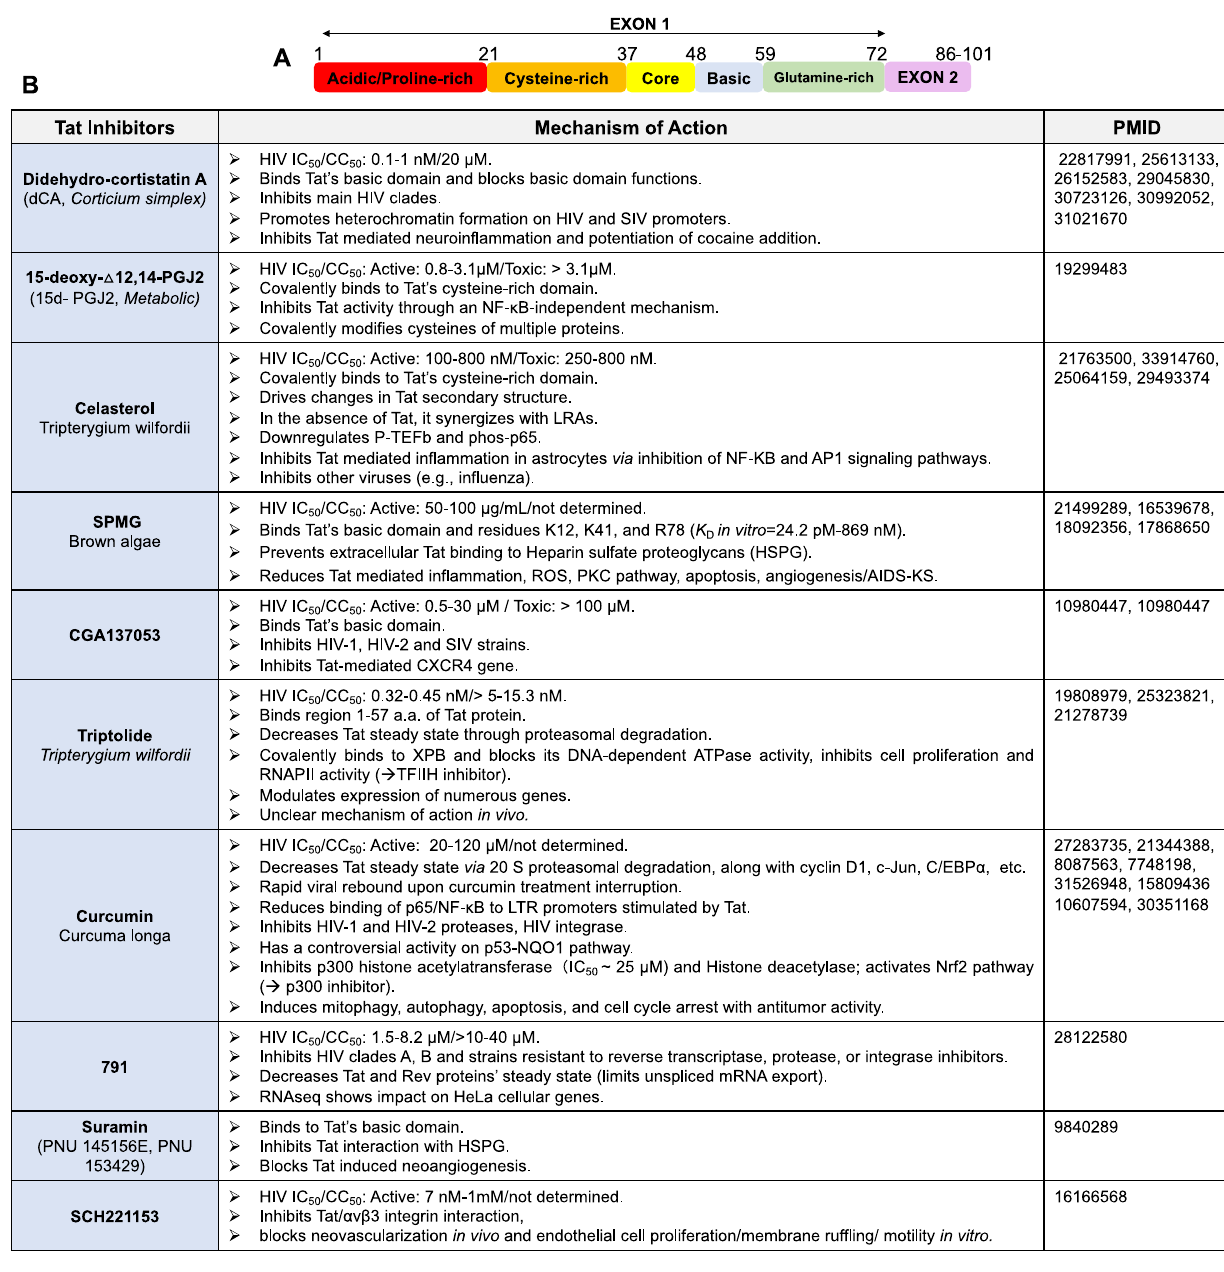
Figure 2. Tat inhibitors. ( A ) Schematic of Tat protein’s domains. ( B ) Inhibitors of HIV Tat protein activities.